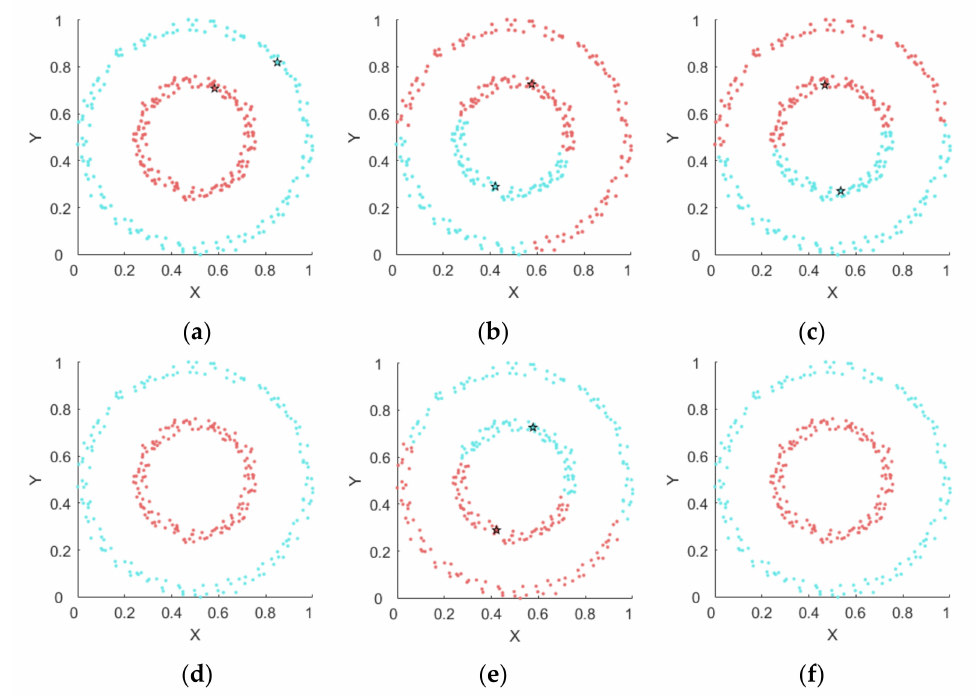
Figure 7. Results on Twocircle. ( a ) ConDPC, ( b ) DPC, ( c ) K-means, ( d ) DBSCAN, ( e ) DPC-DBFN, ( f )